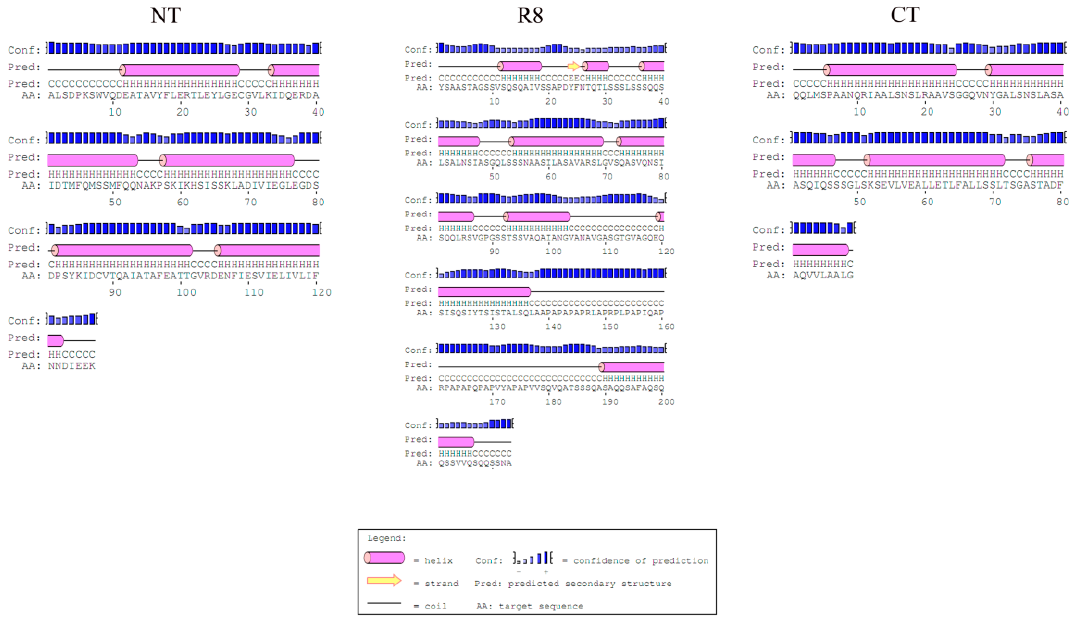
Figure 2. N- and C-terminal domain and repeat unit secondary structures.